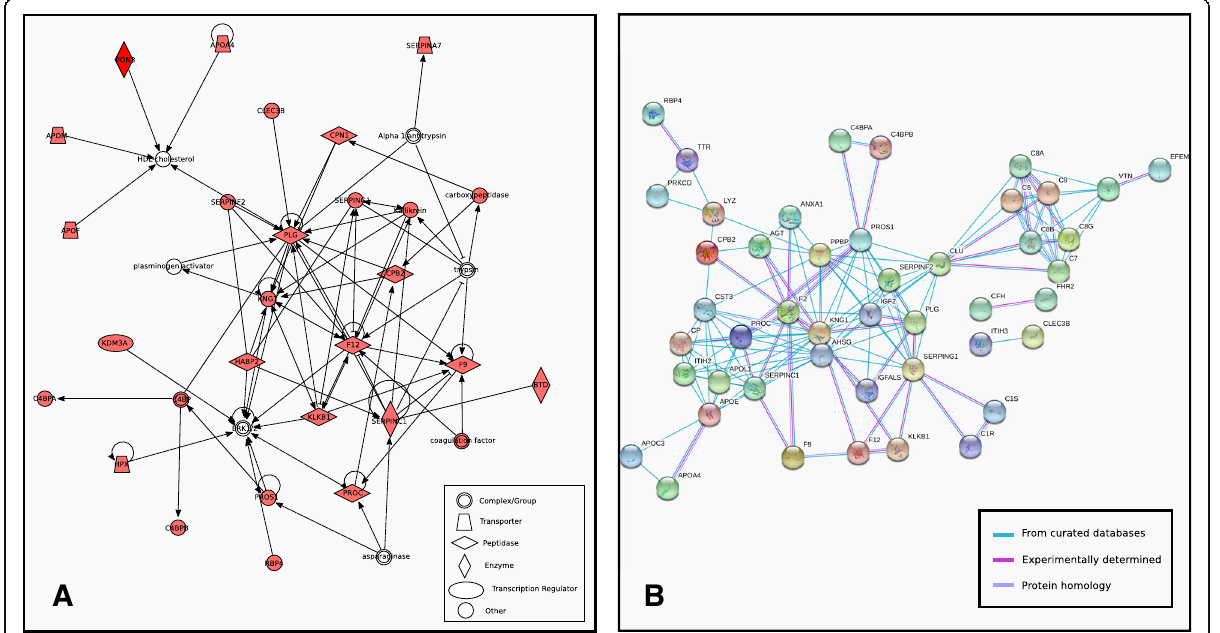
Fig. 2 Pathway analysis for samples from patients with right-sided stage II and III CRC. a shows the top protein-protein interaction network generated by IPA. Proteins in red are proteins that were identified in our study and which displayed higher levels in patients with stage II CRC in the right colon when compared to patients with stage III CRC in the right colon. Proteins in white are proteins that, although not identified in our study, play roles in this network and interact with the proteins identified. b shows the protein interaction network generated by String analysis. The network shows known, direct protein-protein interactions from experiments and databases, without the addition of intermediate proteins not detected in this study, which IPA adds. Only proteins that passed the cutoff of having a Mann-Whitney U test p-value of less than 0.05 were used for pathway